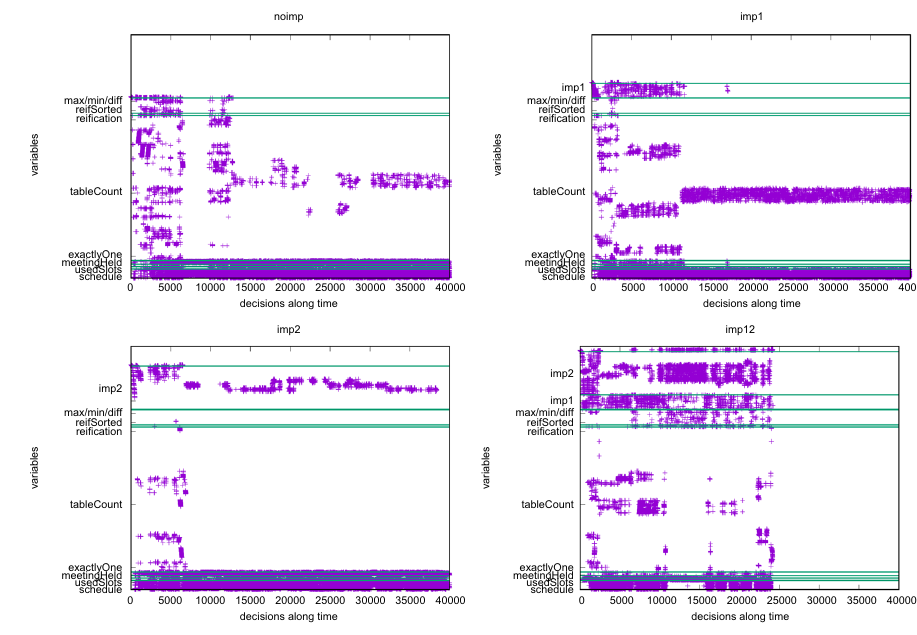
Fig. 6 Branching variables decided by the solver along its execution, for a random B2B instance with high density ( P = 40, M = 150, T = 10, L = 16 ), during their first 40, 000 decisions (solved by imp12 in 24, 169 decisions)